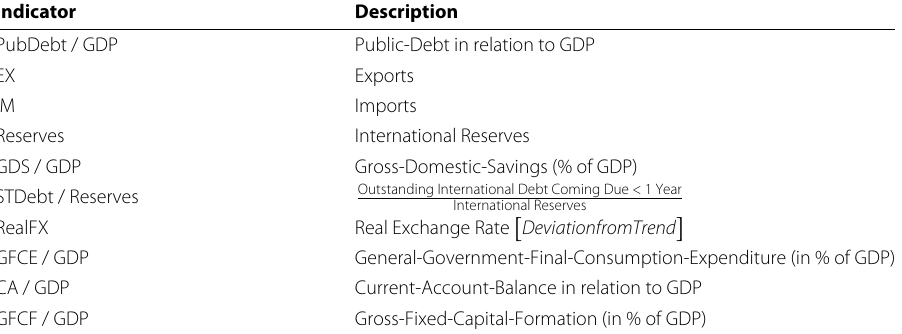
Table 1 Description of Macroeconomic